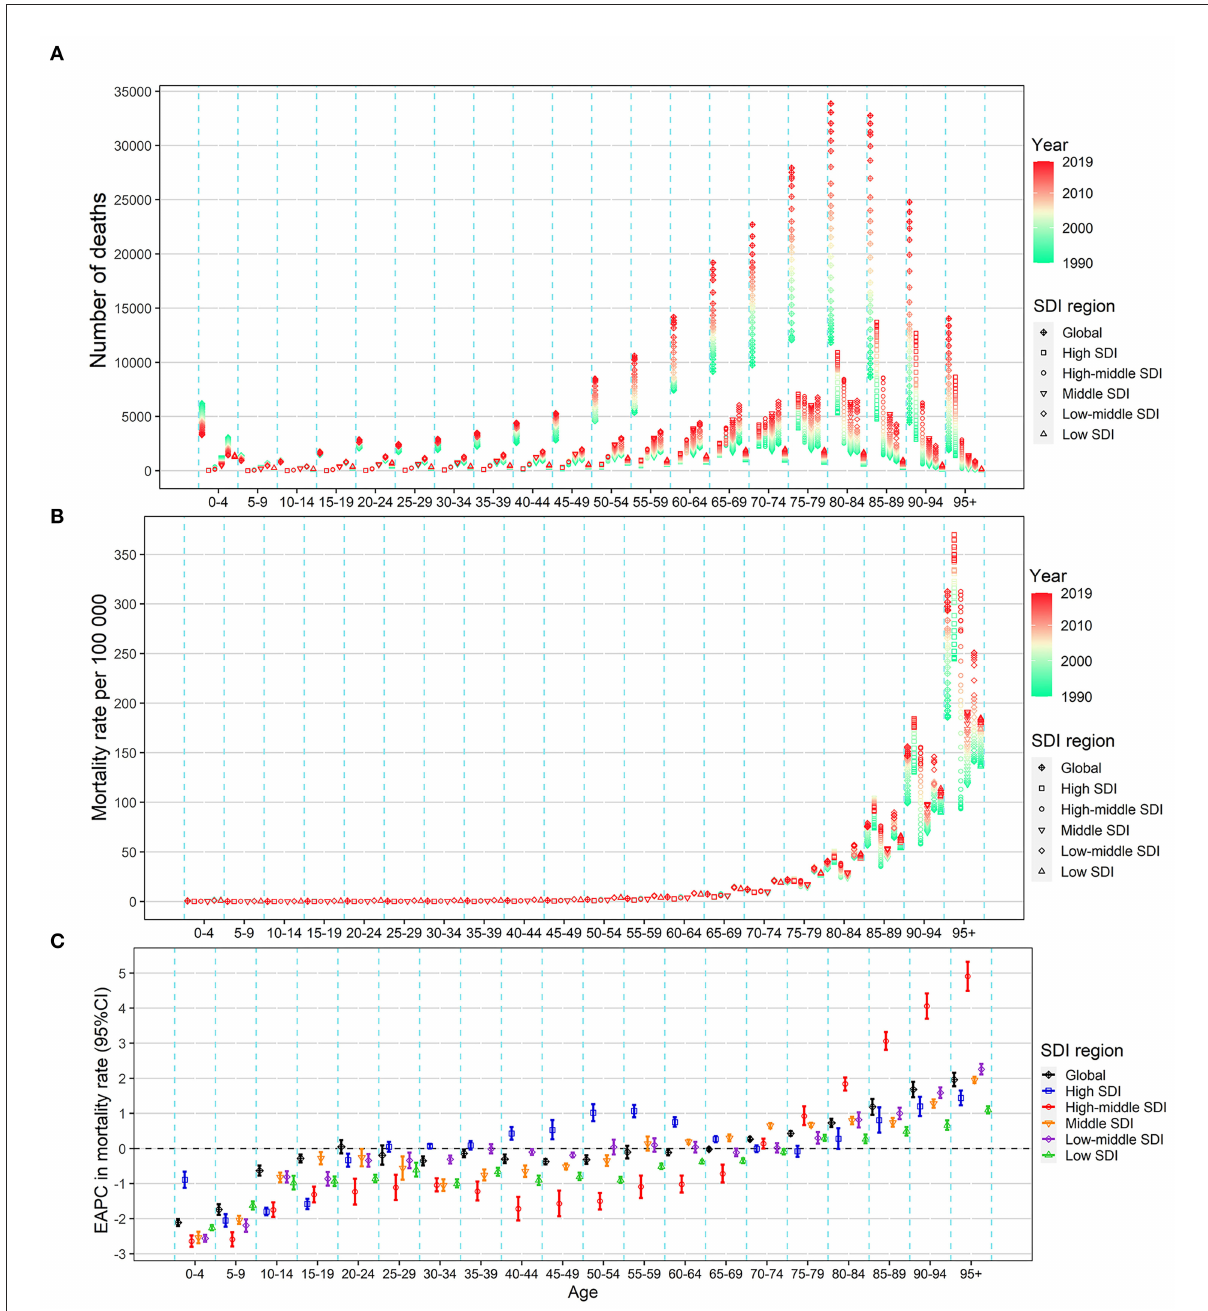
FIGURE4 Change in the mortality of urinary tract infection across all age groups in the worldwide and five SDI regions, both sexes, from 1990 to 2019. (A) Number of deaths. (B) Age-specific mortality rate. (C) EAPC in the age-specific mortality rate of urinary tract infection. EAPC, estimated annual percentage change; SDI, socio-demographic